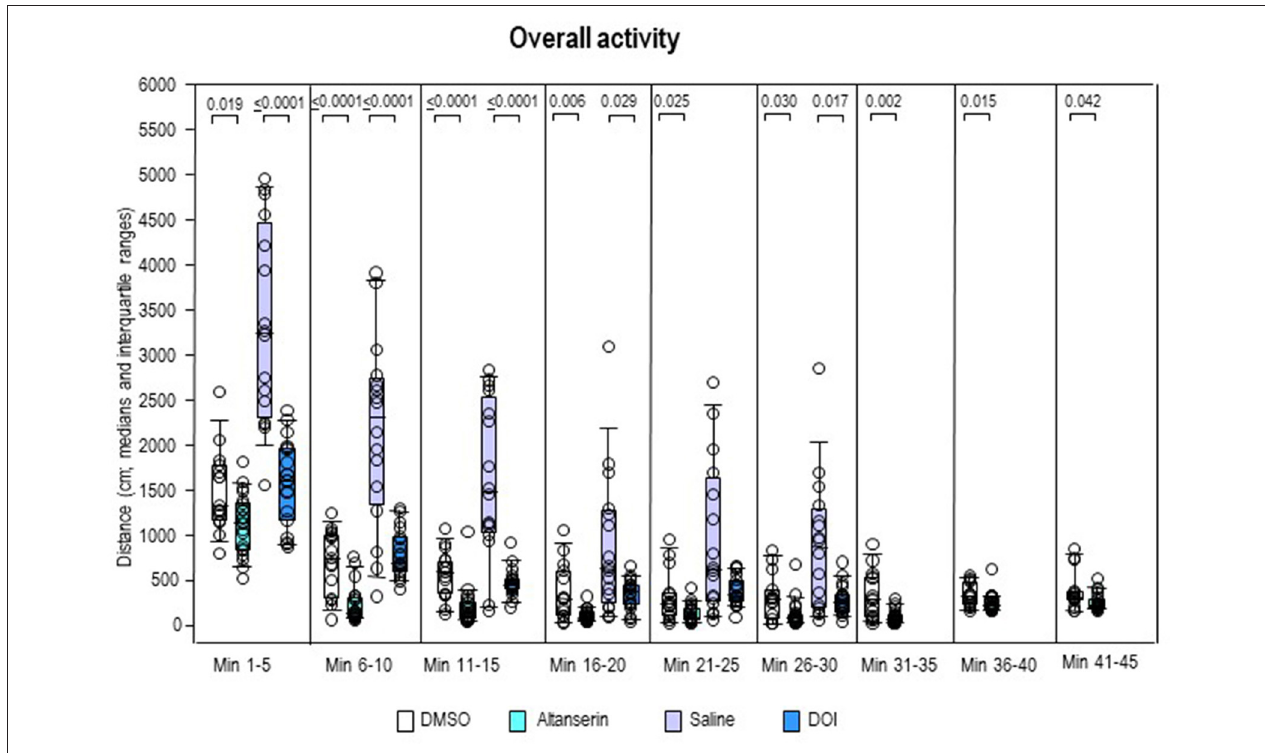
FIGURE 6 | Overall activity. Traveled distance (cm) after 10 mg/kg of altanserin (turquoise), 0.5 mg/kg of 2,5-dimethoxy-4-iodoamphetamine (DOI; blue), and the respective vehicles [dimethyl sulfoxide (DMSO), white; saline, light purple]. The figure shows box and whisker plots of median overall activity in the individual 5-min bins. The 25th/75th percentiles are given in the boxes, while the 5th/95th percentiles are represented by the whiskers. The circles represent the individual animals. Groups (altanserin vs. DMSO; DOI vs. saline) were compared with the independent Mann–Whitney U -test (two-tailed, α = 0.05). Significant p -values are